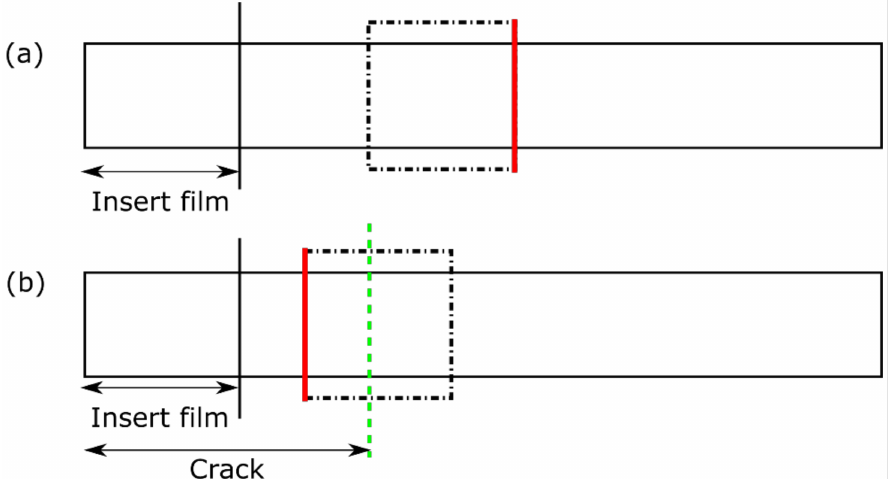
Figure 3. Schematic illustrations of the samples extracted out of the DCB specimens for the micro- scopic examinations: ( a ) Pristine specimens; ( b ) specimens after fatigue mode I DCB testing. The view is on the top specimen surfaces. The green dashed lines refer to the final crack tip after fatigue testing. The black dot-dashed lines refer to the samples cut out of the DCB specimens, with the cross-section surfaces examined using the optical microscope marked in red. The figure is not